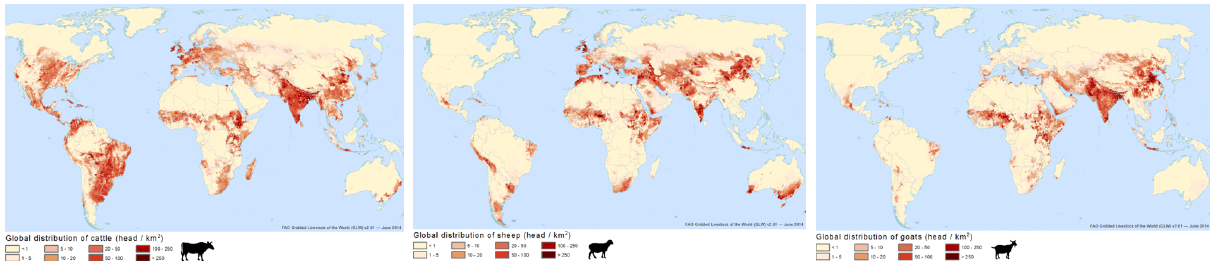
Figure 3. Global distributions of cattle, sheep and goats from the Gridded Livestock of the World database (Robinson et al.,